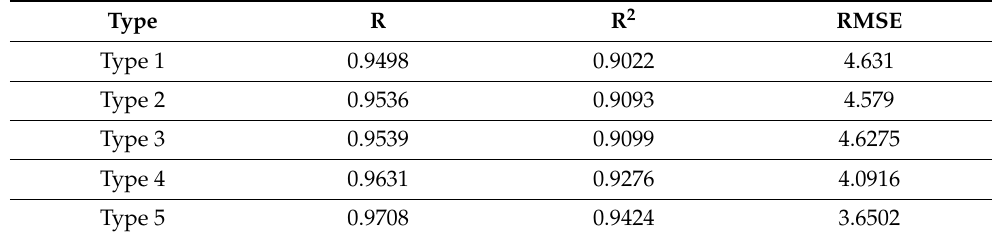
Table 5. Regression analysis results of three-dimensional equations for predicting the peak compres- sive strength of the SMA-confined concrete cylindrical